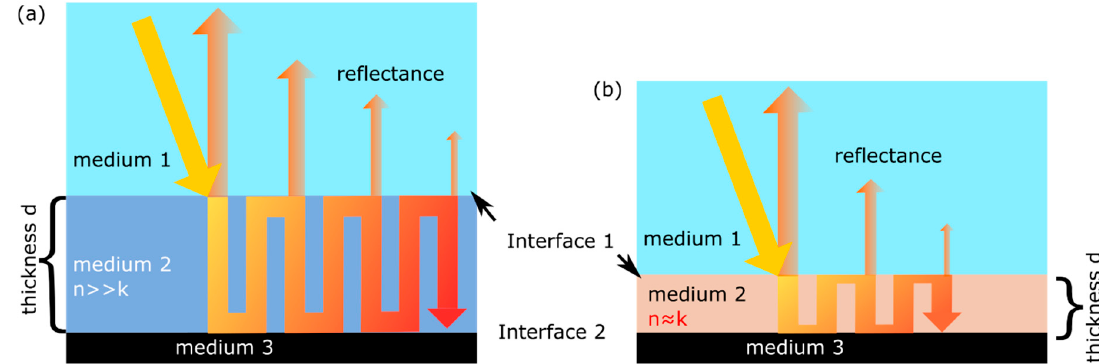
Figure 1. Absorption due to multiple internal reflections in a transparent dielectric ( a ) and an absorptive medium ( b ) on a reflective substrate. medium ( b ) on a reflective